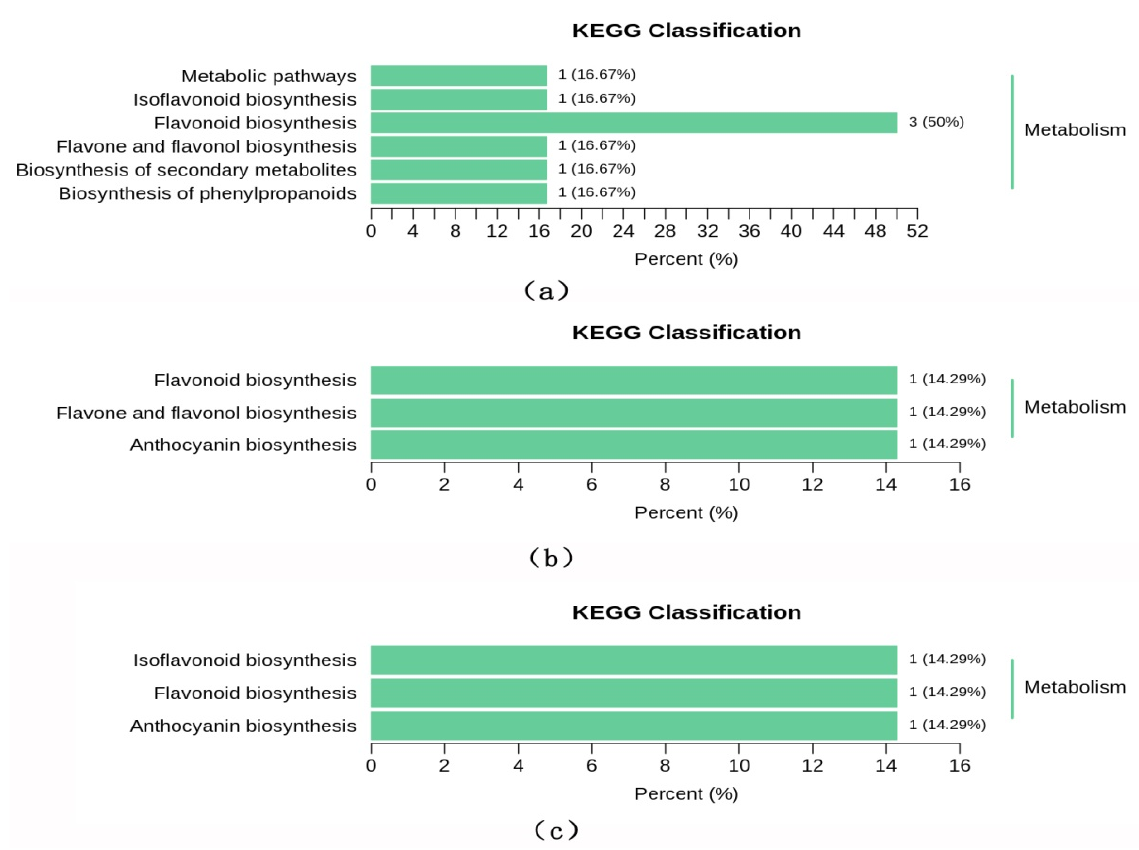
Figure 7. KEGG enrichment of differential metabolites. ( a – c ) KEGG classification of the differential metabolites in comparison group CSG versus CHG, CSG versus CFG and CHG versus CFG. Table 1. List of biologically active, upregulated flavonoid metabolites detected in CSG.